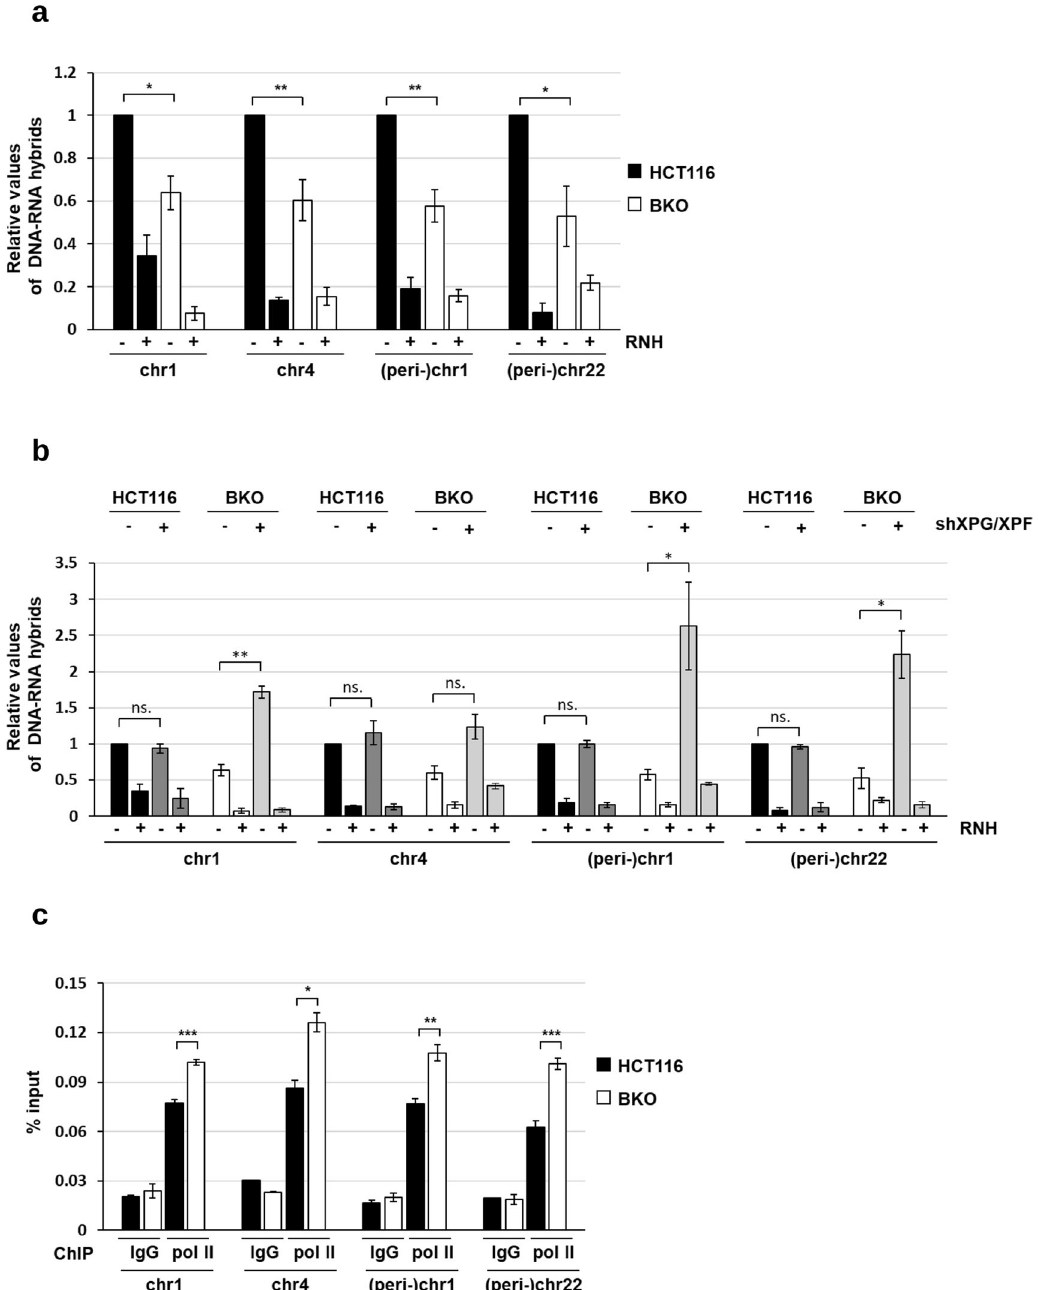
Fig. 5 The regulation of (peri-)centromeric R-loops by XPG/XPF and transcription in BKO cells. a , b Levels of (peri-)centromeric R-loops by DRIP analysis. a HCT116 and BKO cells and b cells with or without XPG/XPF knockdown. All DNA samples were untreated (-) or treated ( + ) with RNase H before immunoprecipitation by S.9.6 antibody. qPCR values of DNA-RNA hybrids at (peri-)centromere sequences of chromosomes are normalized by IgG control. Data are expressed relative to that in HCT116 cells and presented as mean ± SEM of three independent experiments (*, ** P < 0.05, 0.01, ns: no signi fi cant by two-tailed unpaired Student ’ s t -test, RNH: RNase H). c HCT116 and BKO cells were used for Pol II-ChIP-qPCR analysis. Data are shown as the percentage of input DNA in Pol II antibody versus IgG control at (peri-)centromere sequences of chromosomes regions (mean ± SEM, n = 3, *, **, *** P < 0.05, 0.01 0.001, ns: no signi fi cant by two-tailed unpaired Student ’ s t generated by site-speci fi c metastasis. Tet-on expression vectors of PL-SIN- 5TO-Flag-p53-IRES-GFP were constructed by insertion of PCR products ampli fi ed from p53 cDNA at EcoR I (5 ′ ) and BamH I (3 ′ ). and LSM 700 laser scanning confocal microscope (Carl Zeiss). Immuno fl uorescence staining Cells were fi xed with 4% paraformaldehyde for 15 min at room temperature (RT), followed by blocking in 5% BSA/TBS for 1 h at RT and staining with primary antibody overnight at 4 °C. After incubation with a